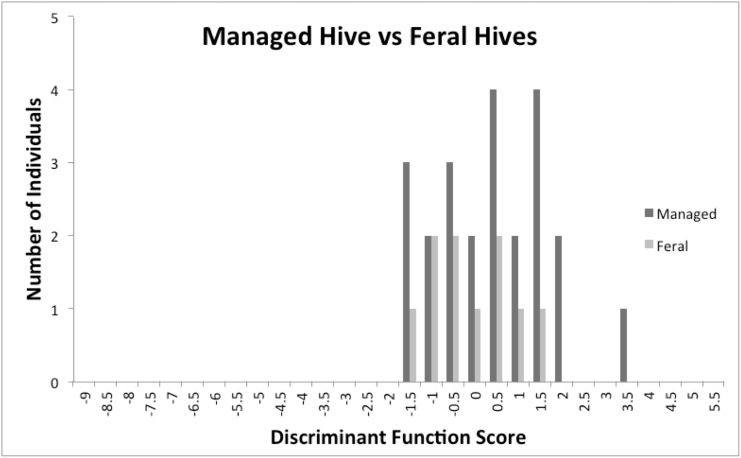
Distribution of morphological discriminant function scores for means of ten workers per colony collected from feral and domestic hives in San Diego County.Arrow indicates the midpoint between the mean discriminant function scores for worker mean measurements from European and Africanized colonies [25]. Colonies with scores smaller than the midpoint are classified by the discriminant function as Africanized while those with scores larger than the midpoint are classified European. The expected misclassification rate of the discriminant function for worker means is 3.5% [25].